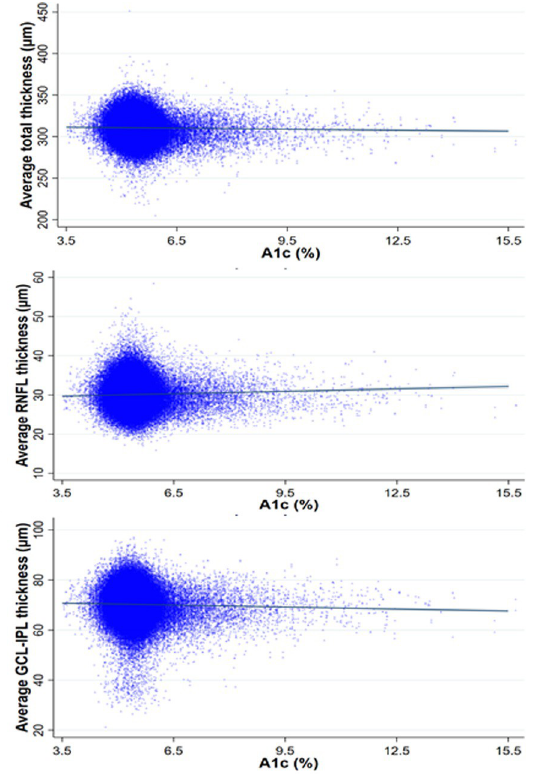
Fig 2. Change in retinal thickness measurements with change in glycated hemoglobin levels. Fig 2 shows the change in a) average total retinal thickness, b) average retinal nerve fiber layer (RNFL) thickness, c) average ganglion cell-inner plexiform (GC-IPL) layer thickness after adjusting for co-variates.